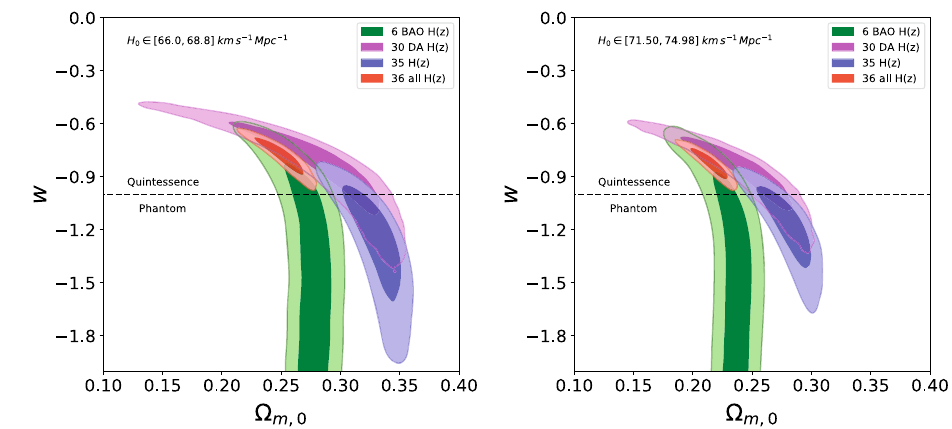
Fig. 3 Constraints on the parameters of wCDM cosmological model obtained using Omh 2 ( z i , z j ) two-point diagnostics. Left panel: with uniform prior H 0 ∈ [ 66 . 0 , 68 . 8 ] km s − 1 Mpc − 1 correspond-